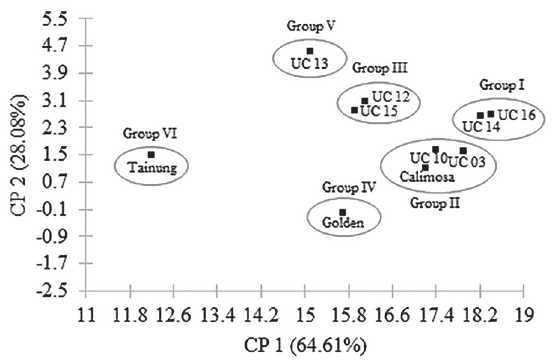
Figure 1 - Projection of the scores for the first two principal components (92.70%) from sensory